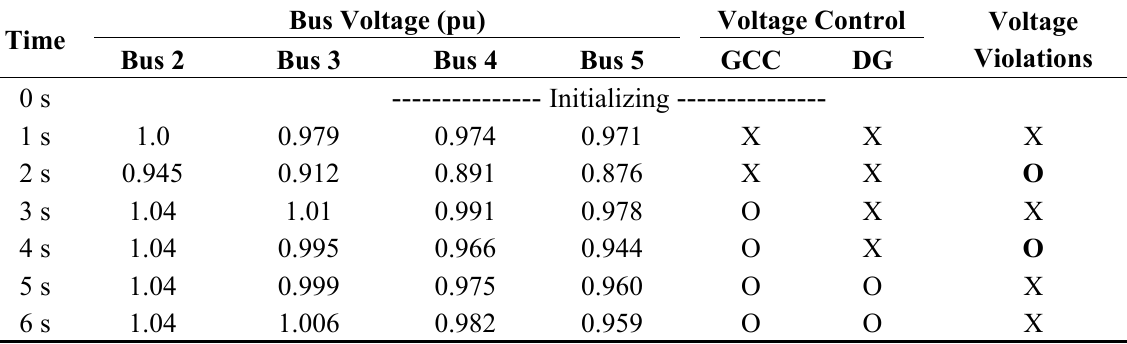
Table 6. Simulation results of Bus voltage and voltage